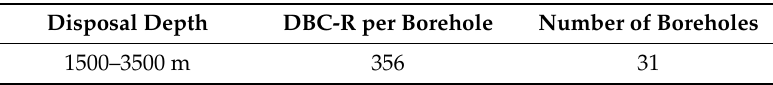
Figure 3. Section of a borehole with casing and container DBC-R. Table 1. Disposal depth, DBC-R per borehole and number of